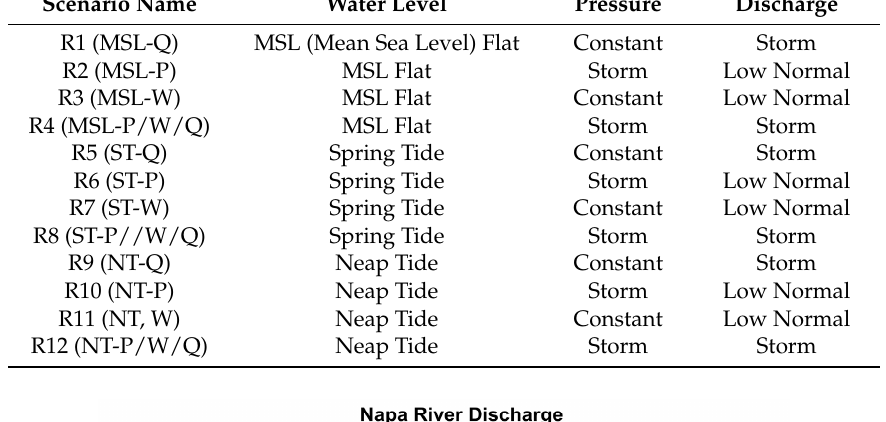
Table 2. Realistic model scenario titles and forcing included.